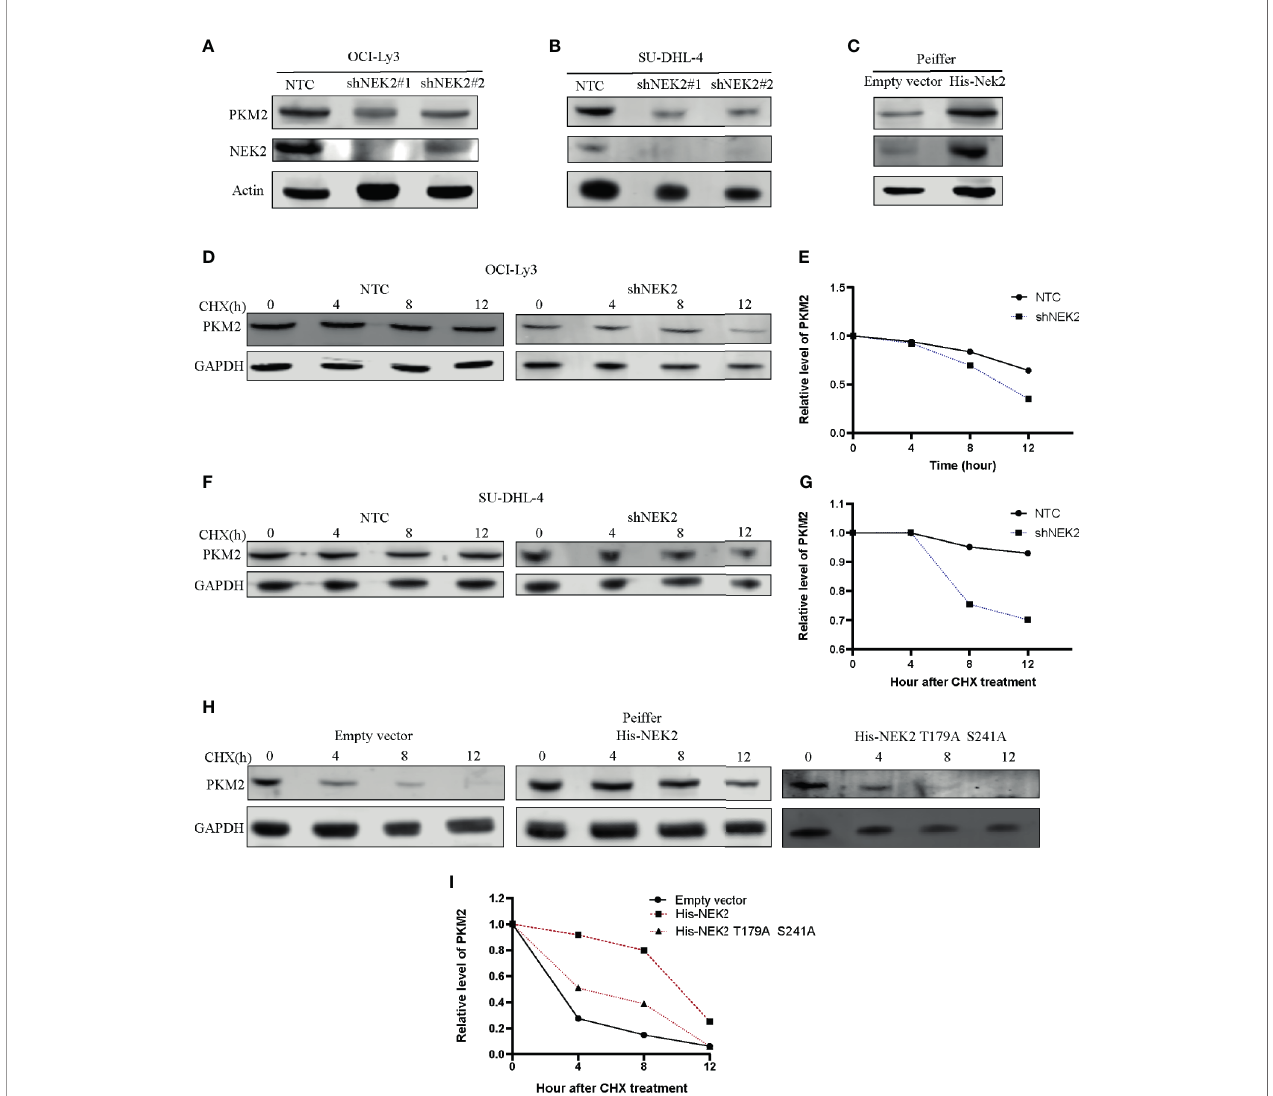
FIGURE 5 | NEK2 increased the abundance of PKM2 protein and regulated the stability of the PKM2 protein in DLBCL cells. (A, B) Knockdown of NEK2 decreased PKM2 protein in OCI-Ly3 and SU-DHL-4 cells; (C) PKM2 protein abundance was increased by forced expression of NEK2 in Peiffer cells; (D – G) Cycloheximide (CHX) treatment was conducted to monitor the protein half-life of PKM2 in OCI-Ly3 and SU-DHL-4 cells. The PKM2 turnover rate in OCI-Ly3 and SU-DHL-4 cells with NEK2 knockdown was lower than control; (H, I) Cycloheximide (CHX) treatment was conducted to monitor the protein half-life of PKM2 in Peiffer cells, overexpression of NEK2 increased the half-life of the PKM2 while inactivated NEK2 (His- NEK2 T179A S241A) failed to increase the half time of